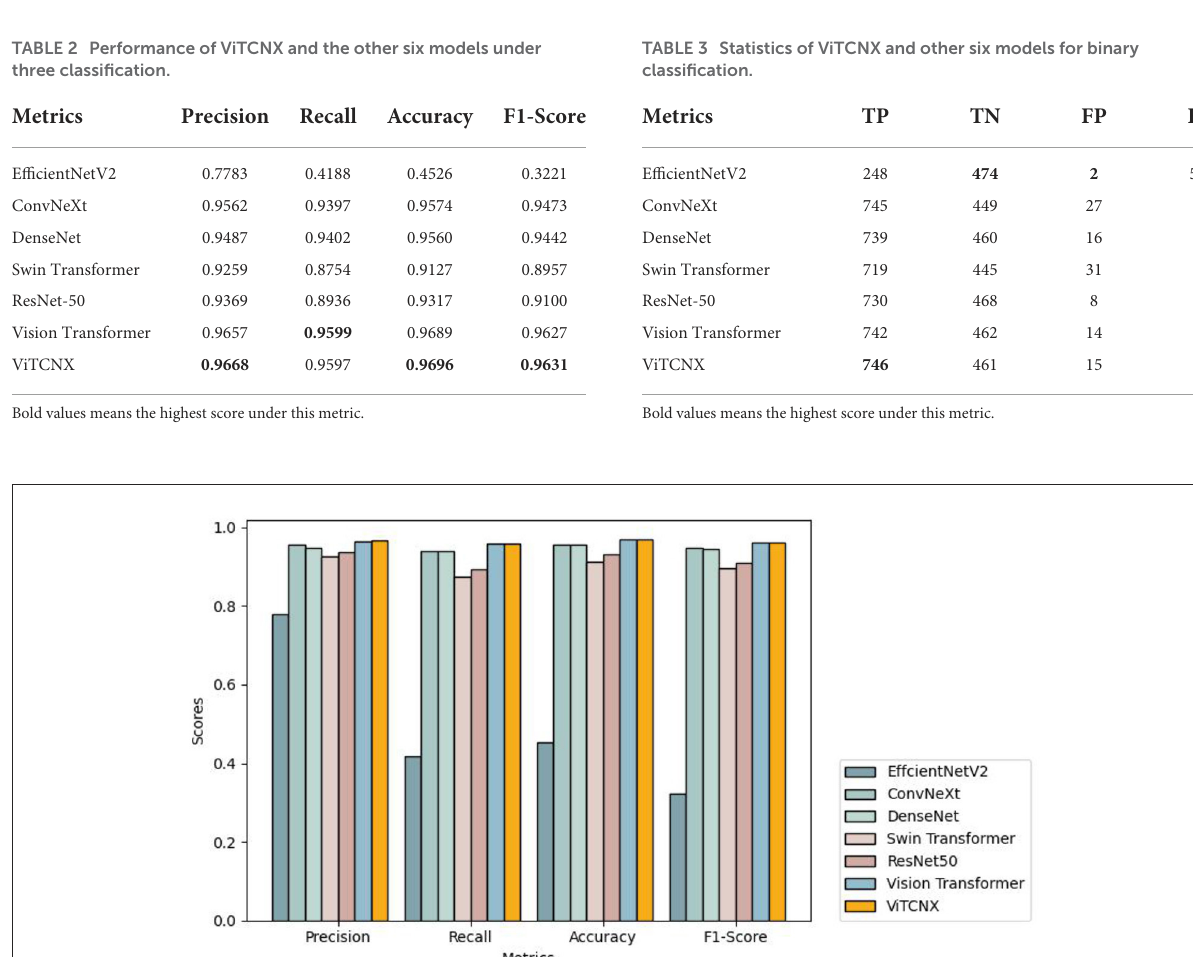
Table 3 and Figure 9 present the statistical data of TP, TN, FP, and FN from the above seven models for binary classification. The importance of these four evaluation metrics is not equal. For COVID-19 image recognition, TP denotes the number of images that are COVID-19 images in the dataset and are predicted to be COVID-19-related. FN denotes the number of images that are COVID-19 images but are predicted to be non-COVID-19-related. FN denotes that there are undetected COVID-19 patients, which may cause the spread of the pandemic. TP and FN are more important than the other two metrics. Higher TP and lower FN represent the better performance of ViTCNX.